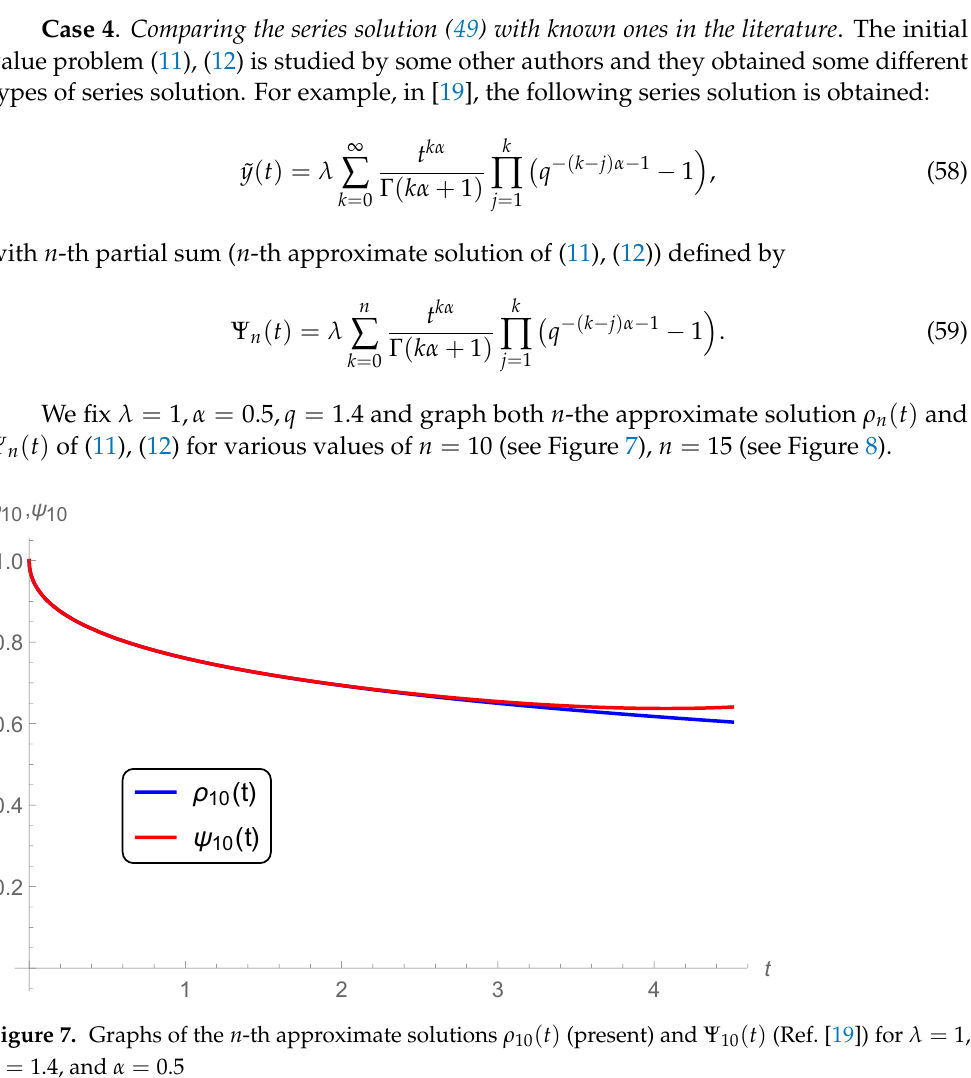
Figure 6. Impact of the initial value λ on the 10-term approximate solution of (11), (12) at q = 1.5, and α = 0.5.